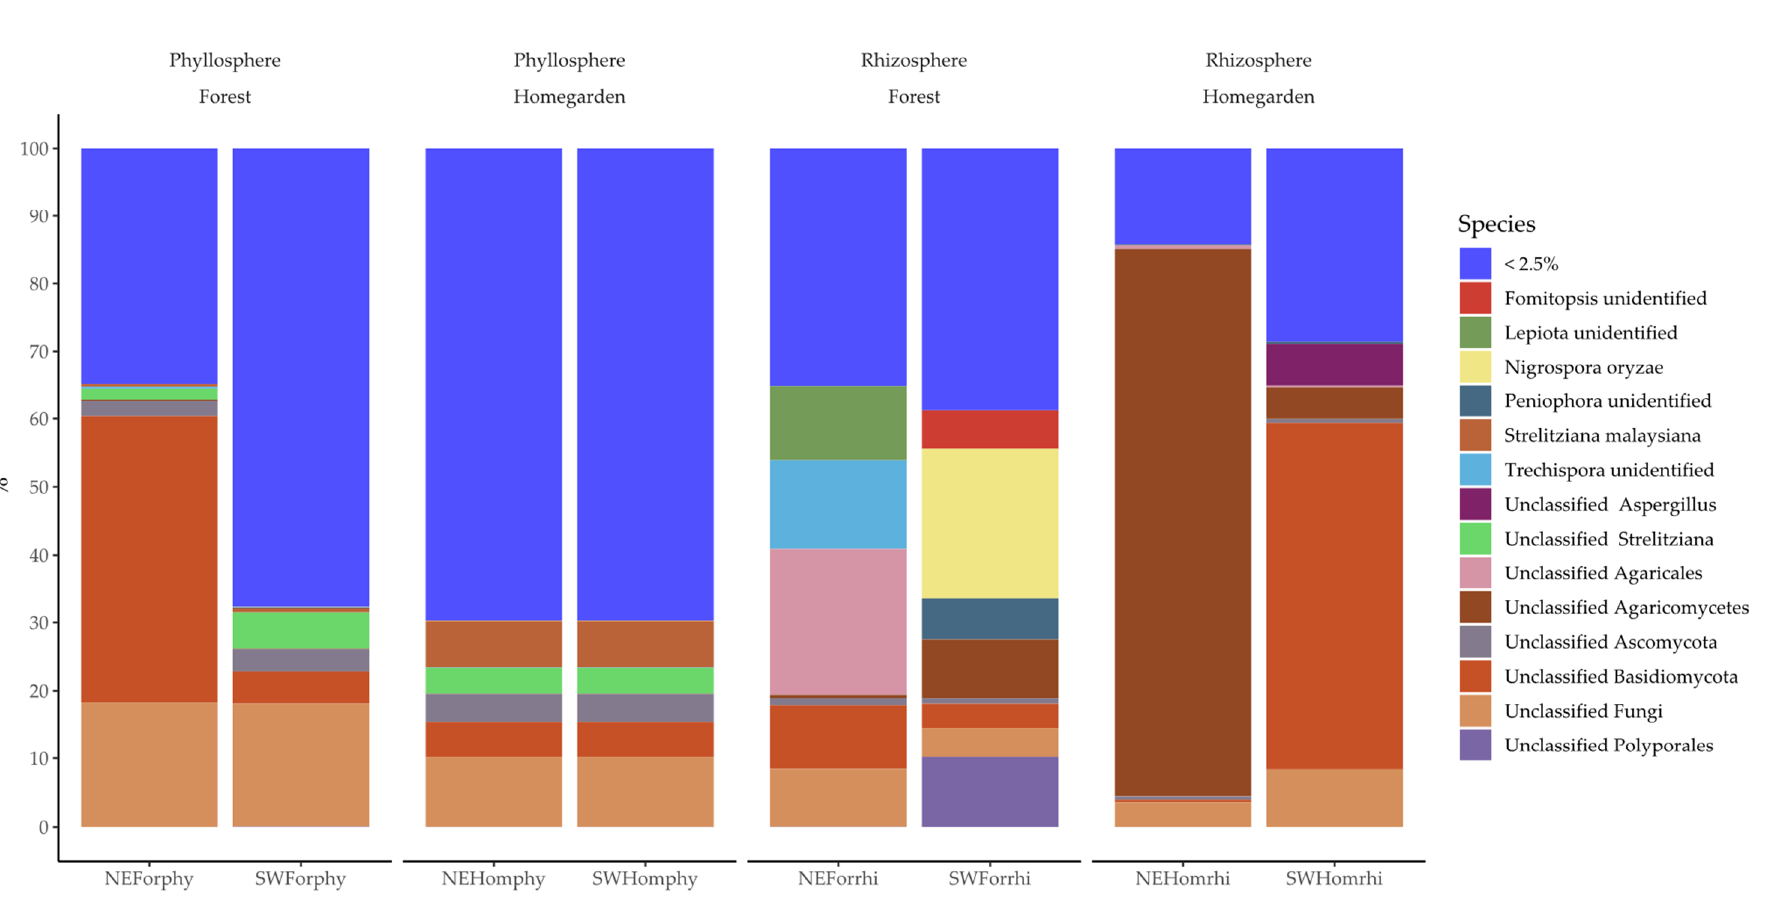
Figure 5. Relative frequency of 1096 fungi OTUs from phyllosphere and rhizosphere microbiota in Yucatán´s forest and homegarden populations of Cordia dodecandra .